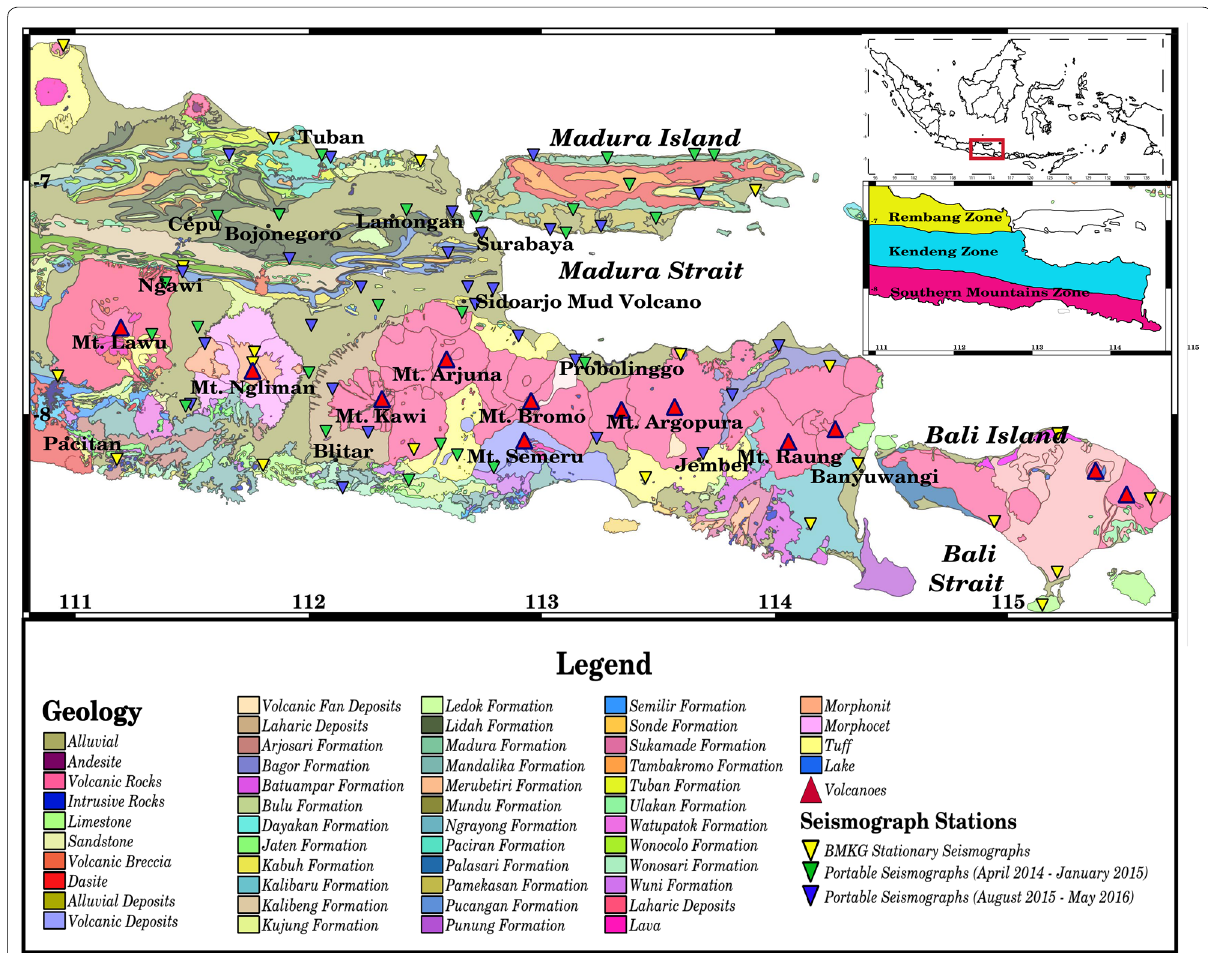
Fig. 1 Map of seismographic stations used in this research overlaid on a geological map [modified from Gafoer and Ratman (1999); Purbo-Hadiwid- joyo et al. (1998)]. The crustal character [modified from Smyth et al. (2008)] and the approximate location ( red square ) of the research are shown in the inset